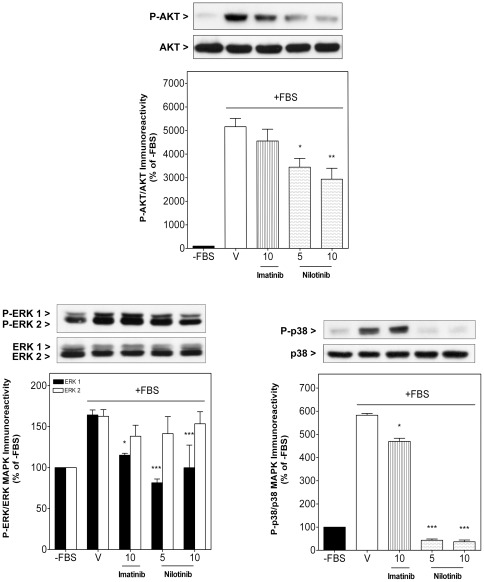
Nilotinib decreased fetal bovine serum-induced AKT activation and fully blocked ERK1/2 and p38 MAPK activation.Sub-confluent synovial sarcoma SW982 cells were deprived of fetal bovine serum (FBS) for 4 h. Cells were then stimulated for 30 min with 10% FBS in the absence (vehicle, V) or presence of imatinib (10 µM) or nilotinib (5 and 10 µM) as single compounds. Upper panels show representative immunoblots of four independent experiments. Columns represent the phosphorylated ratio of AKT, ERK1/2 and p38 MAPK. Each column represents mean ± SEM of four independent experiments normalized to FBS-depleted cells (-FBS, taken as 100%). *
P<0.05; **
P<0.01 and ***
P<0.001 versus vehicle-treated cells stimulated with FBS.